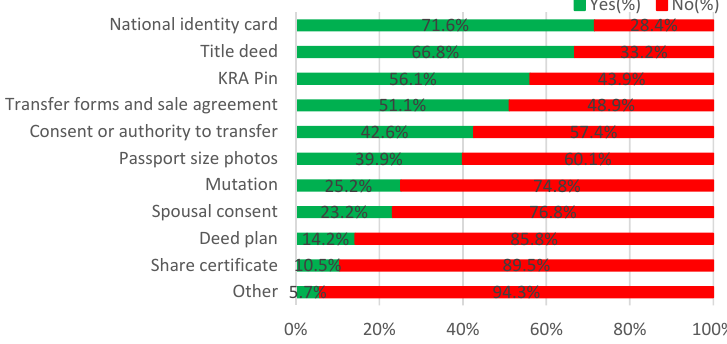
Figure 4. Documentation needed to make inquiries ( n =